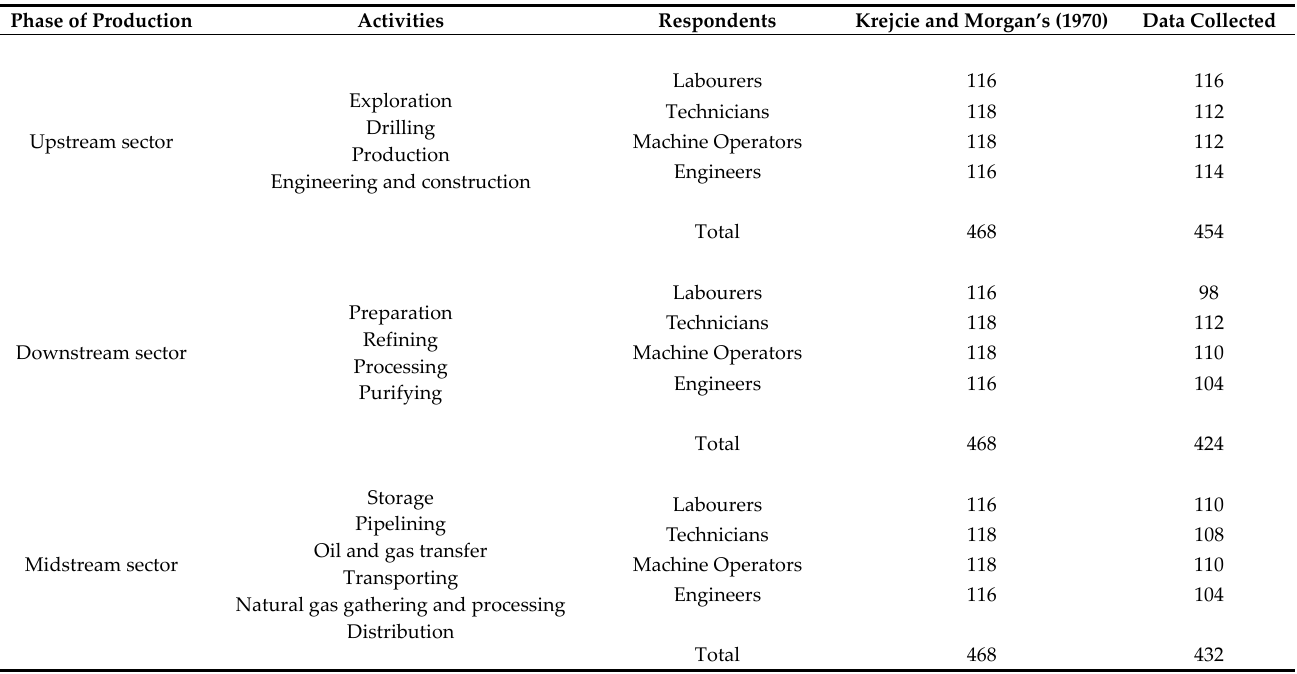
Table 1. Population and Sample Distribution of respondents.